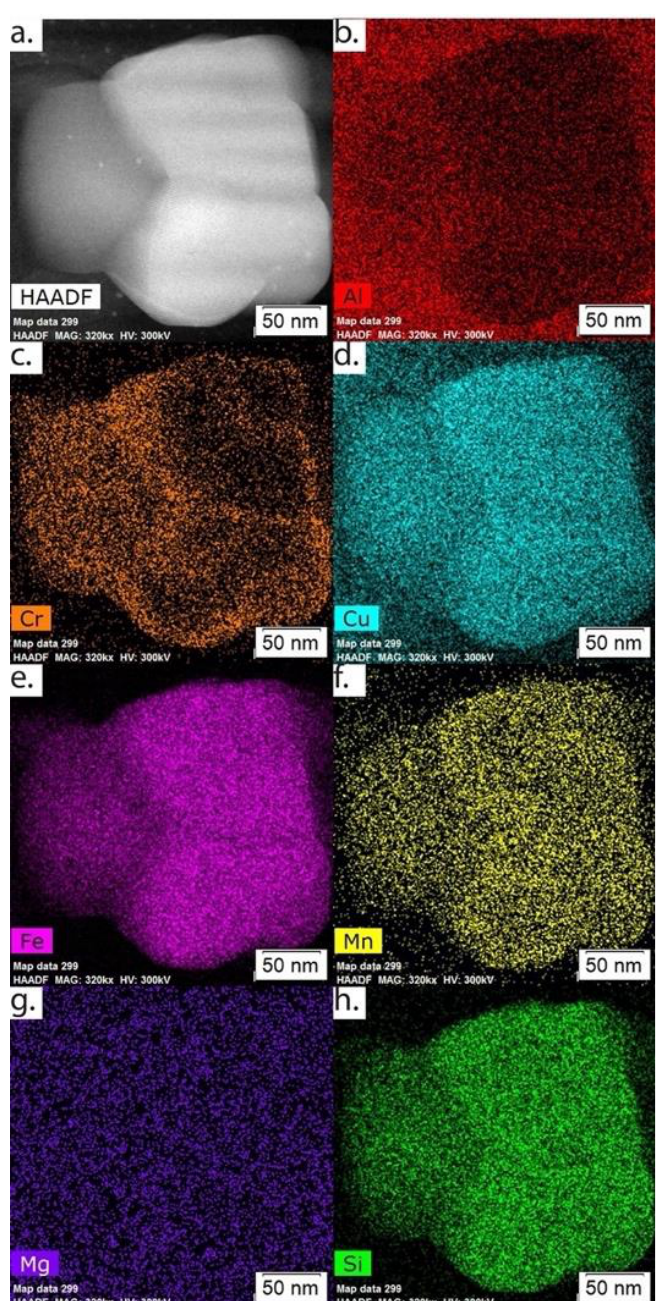
Figure 7. ( a ) HAADF, and EDS maps of ( b ) Al, ( c ) Cr, ( d ) Cu, ( e ) Fe, ( f ) Mn, ( g ) Mg, and ( h ) Si showing the morphology of Al 15 Si 2 M 4 in the thermally treated powder.